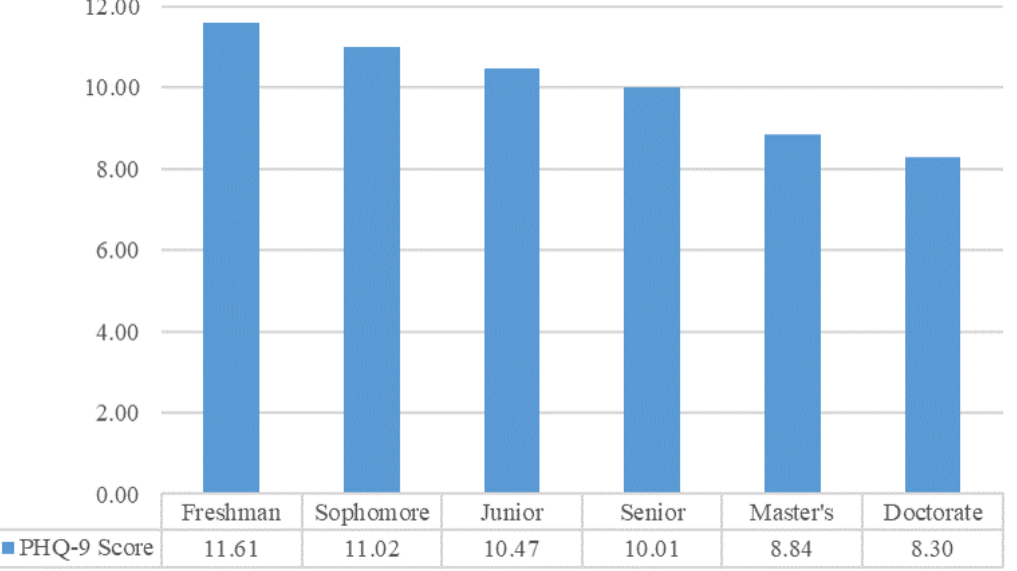
Figure 1. Mean Patient Health Questionnaire-9 (PHQ-9) score by classification.